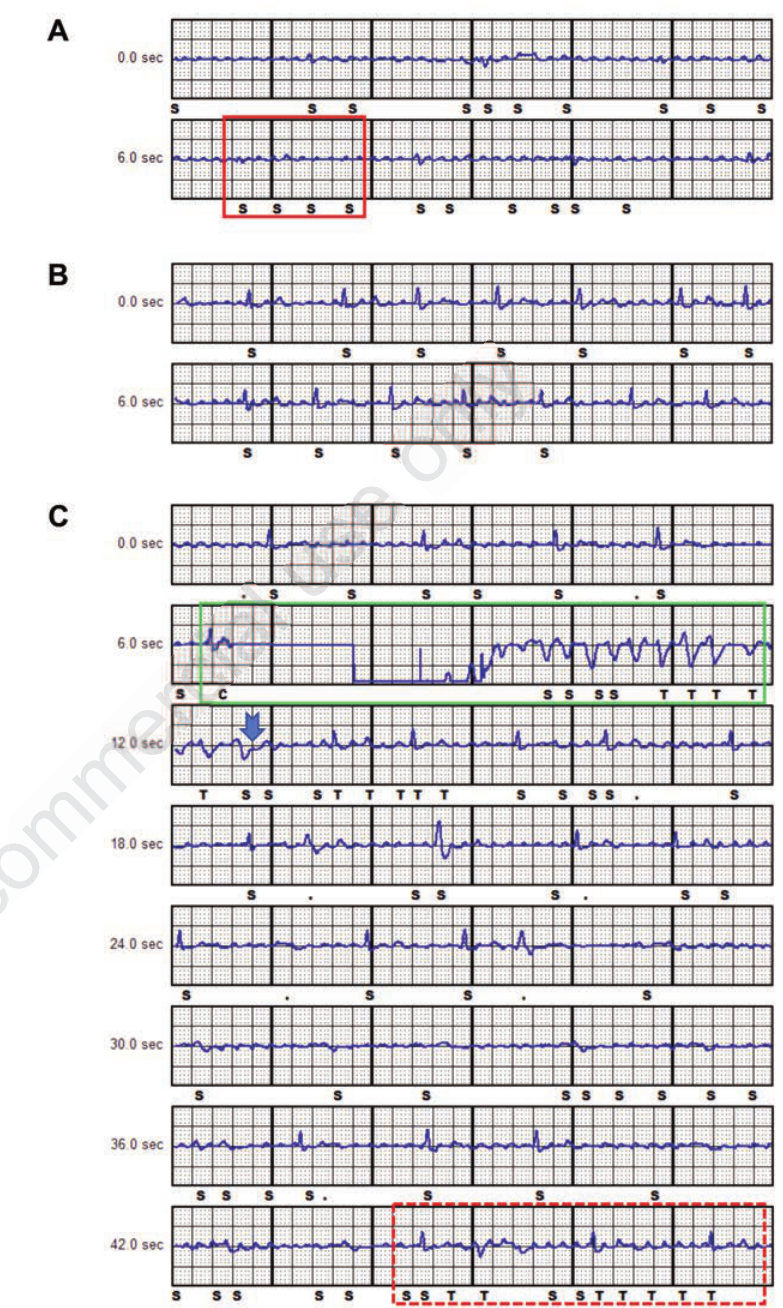
Figure 2. S-ICD tracings from intra-operative testing. A) The S-ICD falsely recognizes atrial fibrillation waves as QRS complexes (S = sensing of a QRS complex, red box). B) After administration of isoproterenol (3 ug/min.), QRS detection improves, but still is far from perfect. C) Ventricular fibrillation is induced for defibrillation testing. VF (T) is detected with some QRS drop outs (green box) and then terminates spontaneously (blue arrow). Finally, the device senses atrial fibrillation waves again as QRS complexes and therefore as ventricular tachyarrhythmia (T) due to an increased sensitivity after a previ- ous episode of VF) (red dotted box), and the device starts charging the defibrillator, which was manually aborted (not